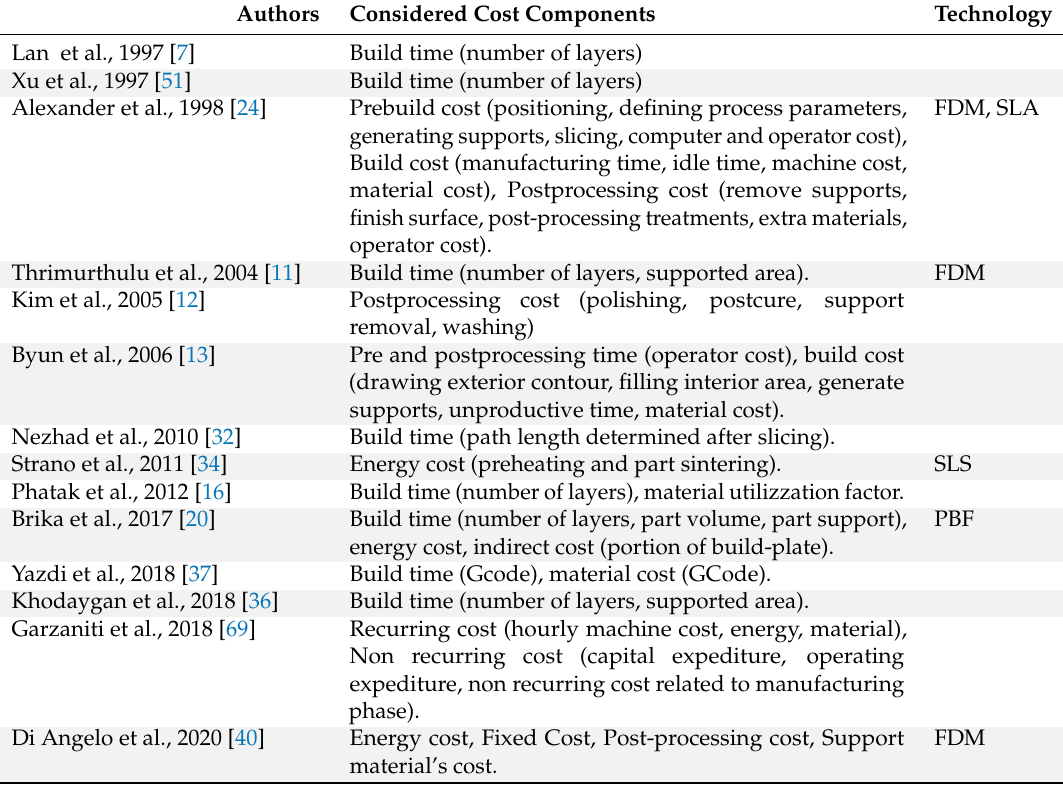
Table 2. Summary of the most relevance cost models proposed in optimization